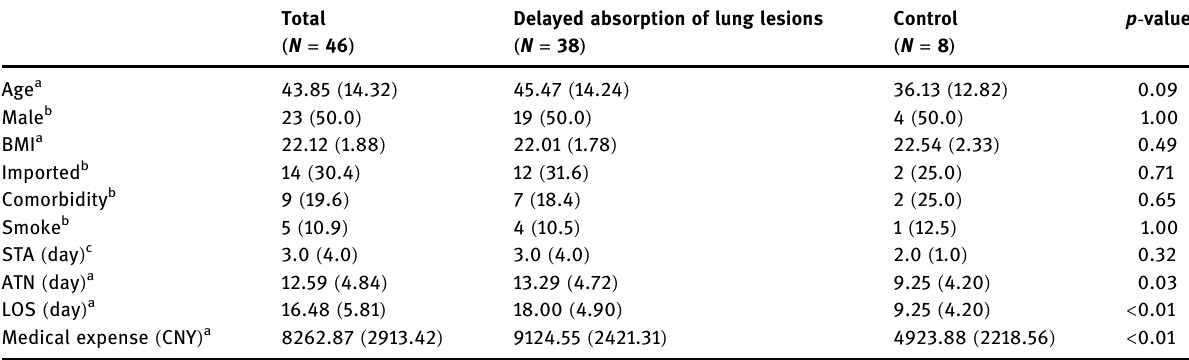
Table 1: Comparison between cases with delayed absorption of lung lesions and non - delayed cases Total Delayed absorption of lung lesions